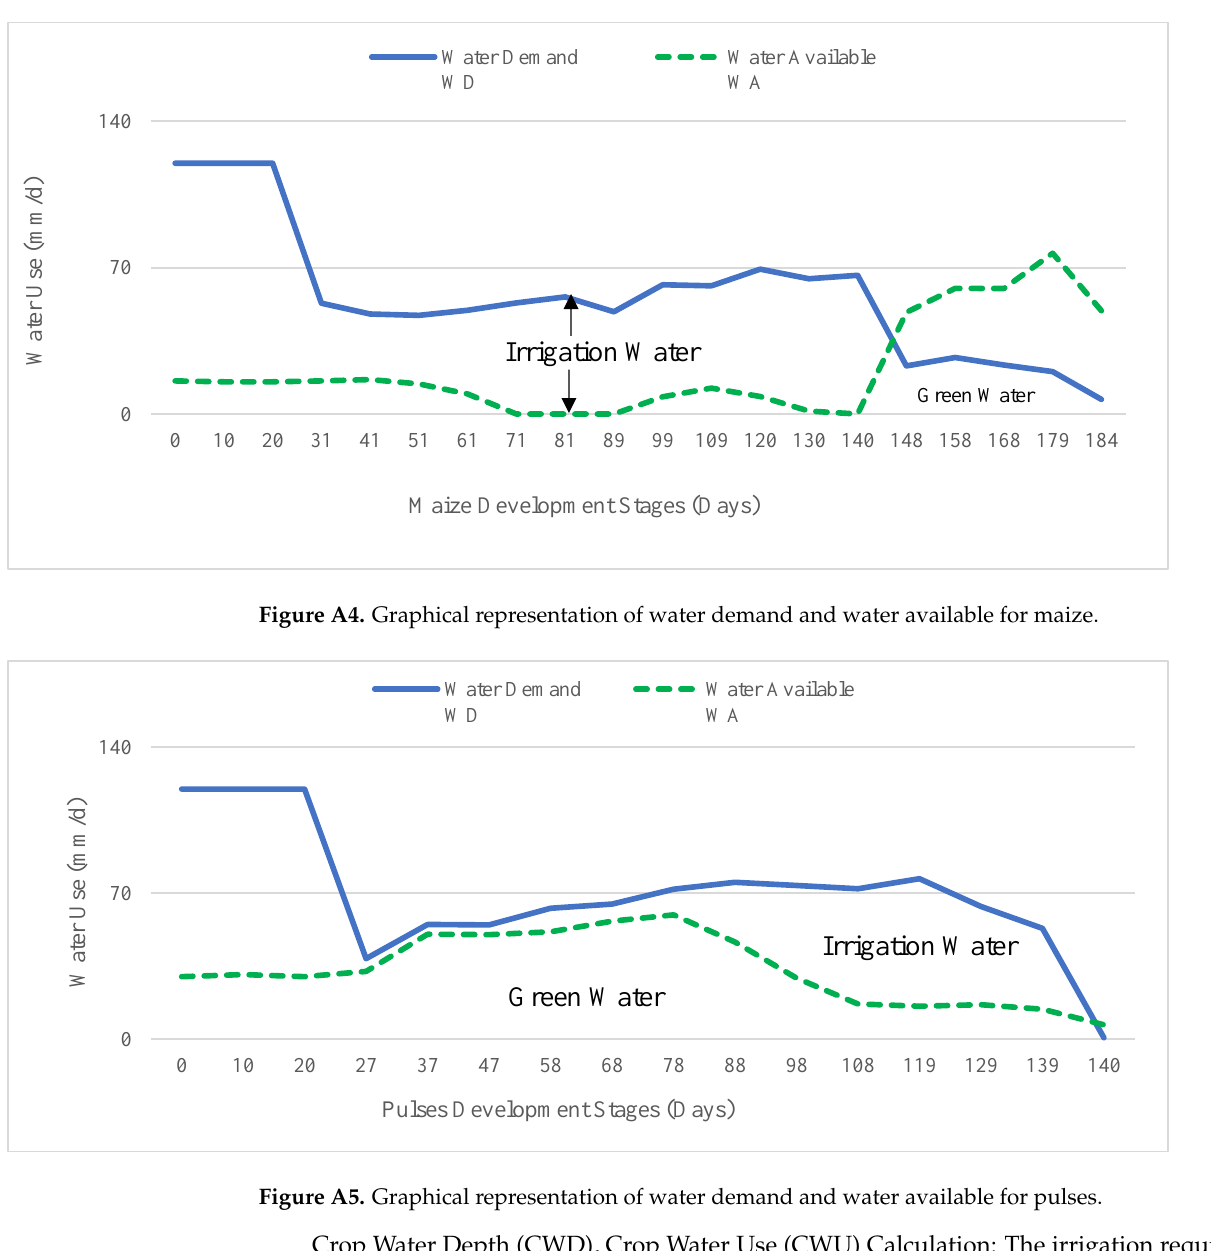
otranspiration ( ETc ) and effective rainfall ( P eff ). Blue Crop water depth (CWD blue ), i.e.,